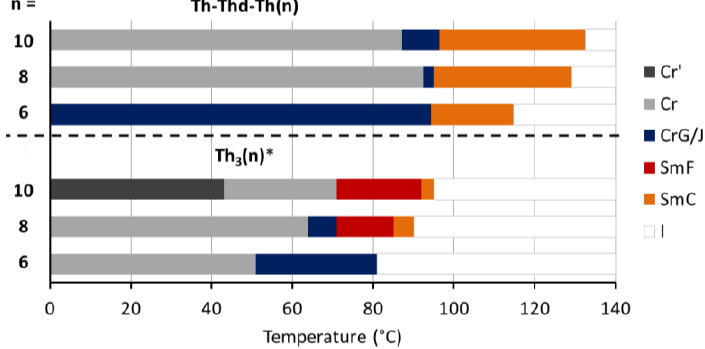
Figure 5. Phase behaviour of Th-Thd-Th( n ) (this work) and Th 3 ( n ) (*literature) [74].